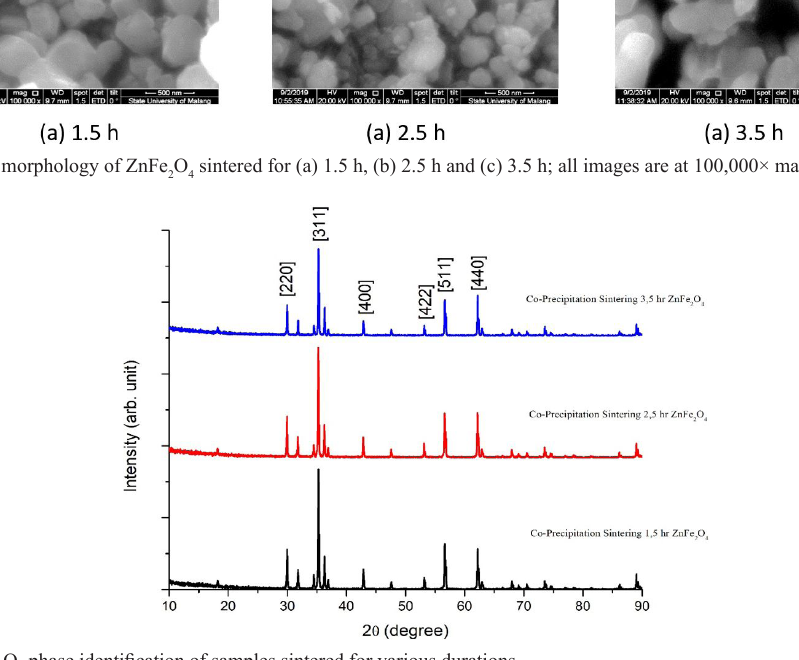
O phase identification of samples sintered for various Figure 2. ZnFe 2 4